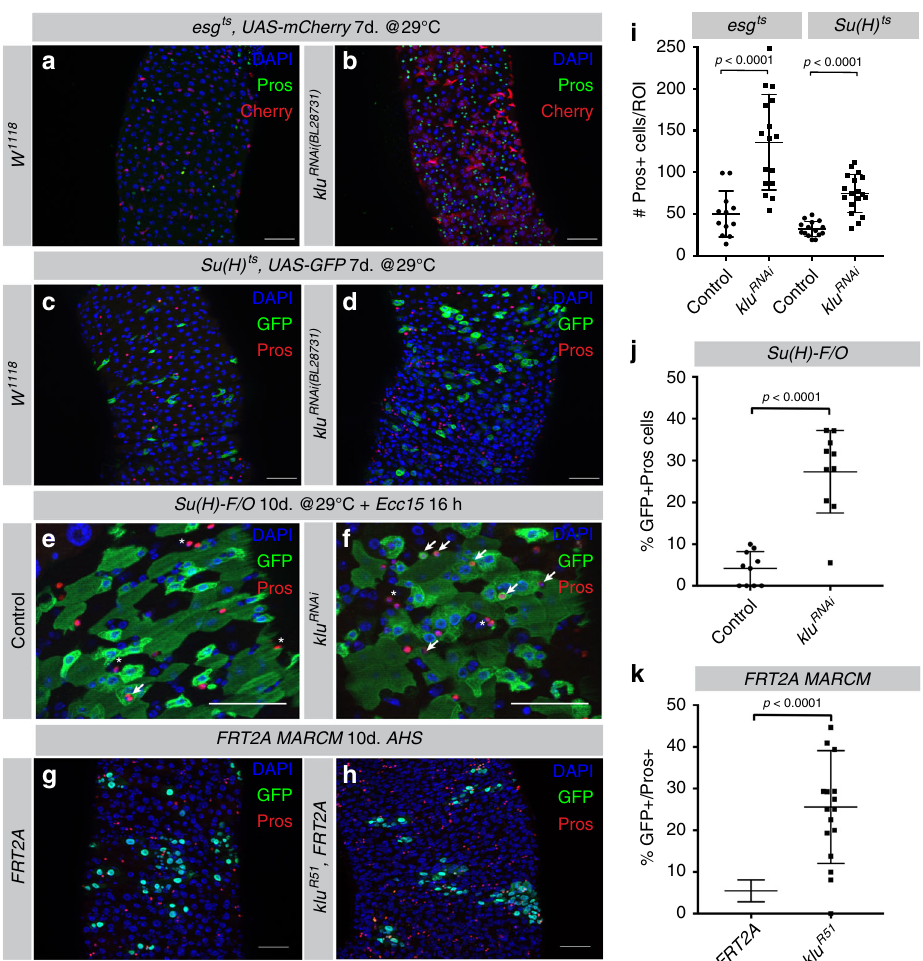
Fig. 2 Loss of Klu leads to excess EE differentiation. a – d RNAi-mediated knockdown of Klu results in an excess of Pros-positive EE cells. Expression of klu RNAi using the ISC + EB driver esg-Gal4 ts (Pros in green, compare a with b ) or the EB-speci fi c Su(H)GBE-Gal4 ts driver (Pros in red, compare c with d ). e , f Su(H)-GBE -driven FlipOut ( Su(H)-F/O ) clones expressing klu RNAi show an increased number of Pros-positive EE cells in the clonal area upon Ecc15 infection compared to controls ( e compare with f quanti fi cation in j ). g , h Clonal analysis of control FRT2A ( g ) or FRT2A, klu R51 ( h ) null mutant MARCM clones. Representative areas of posterior midguts are shown. i EE cell quanti fi cation of the posterior midgut for the genotypes in a – d . Number of midguts n = 12 (control w 1118 ) and n = 16 ( klu RNAi ) for a and b and n = 15 (control w 1118 ) and n = 18 ( klu RNAi ) in c and d . j Quanti fi cation of GFP-Pros double-positive cells/ROI in control and klu RNAi -expressing Su(H)-F/O clones in e and f . n = 10 for control and n = 10 for klu RNAi guts. k Quanti fi cation of the number of Pros-positive EEs/clone and the total number of Pros-positive EEs/ROI for the genotypes in g and h . n = 15 guts ( FRT2A control) and n = 17 guts ( klu R51 ). For quanti fi cations in i – k : error bars represent mean ± SD. Signi fi cance was calculated using Student ’ s t -test with Welch ’ s correction. Scale bar = 50 µ